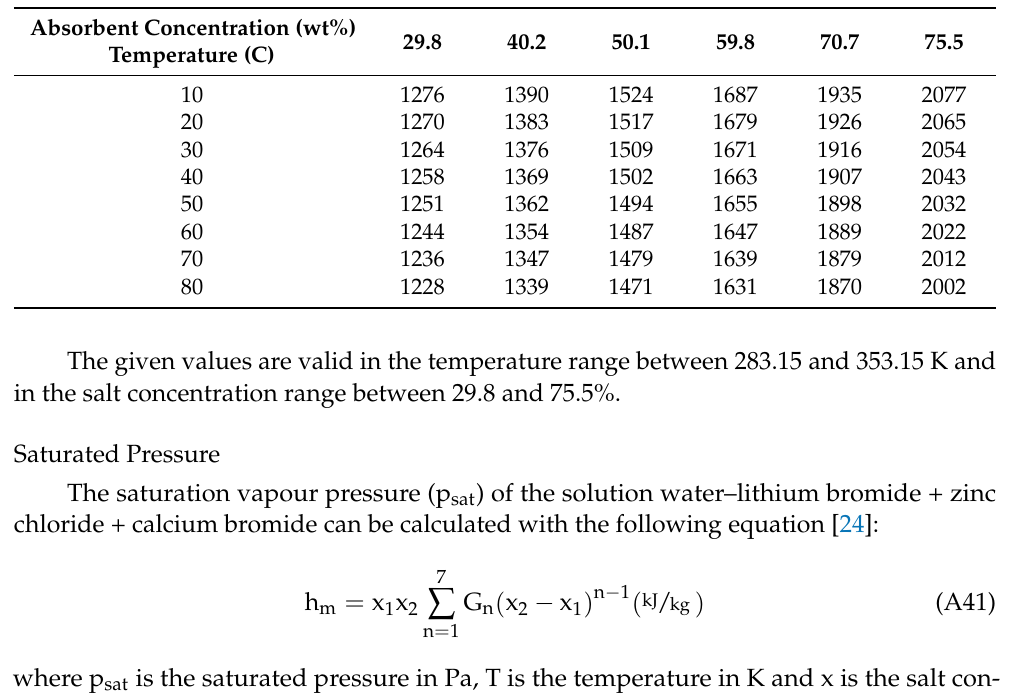
Table A16. Density of the solution H 2 O-LiBr + LiNO 3 .